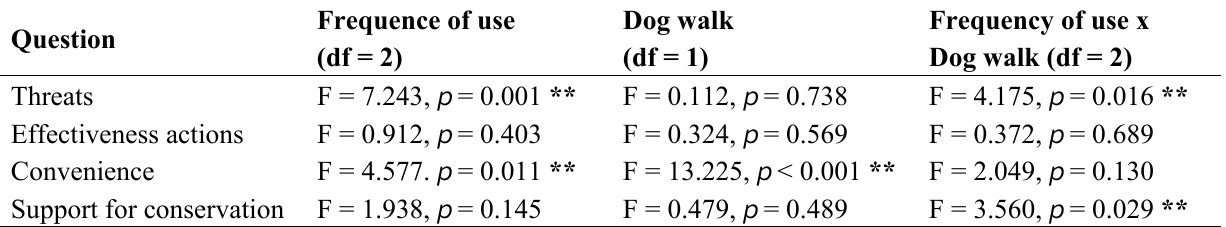
Table 7. Repeated measures ANOVA output on mean PCA scores for each identified reliable factor. ‘Dog walk’ referring to whether respondents walked their dog on beaches (0 = No, 1 = Yes) and frequency of beach use by respondents (where 1 = once a year to several times a year, 2 = several times a month to monthly, and 3 = daily to weekly), plus interaction term. Significant results are denoted as ** = p <